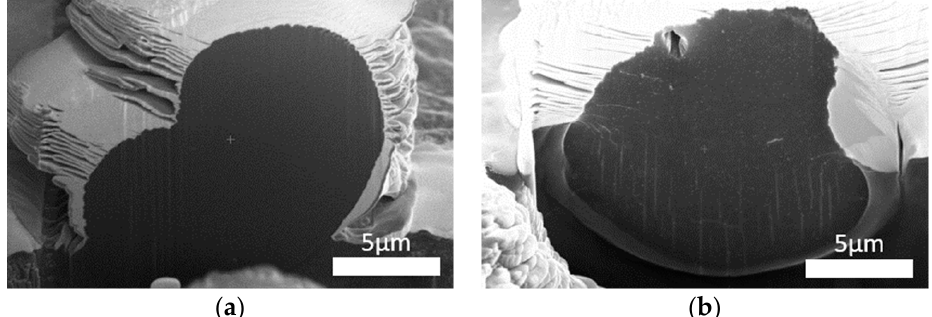
Figure 3. Fiber cross-sections (SEM images): ( a ) non-doped; ( b ) containing AgNPs. SEM imaging, performed in the material contrast mode, showed that silver nanoparti- cles were distributed uniformly in both sections of the fiber (Figure 4).